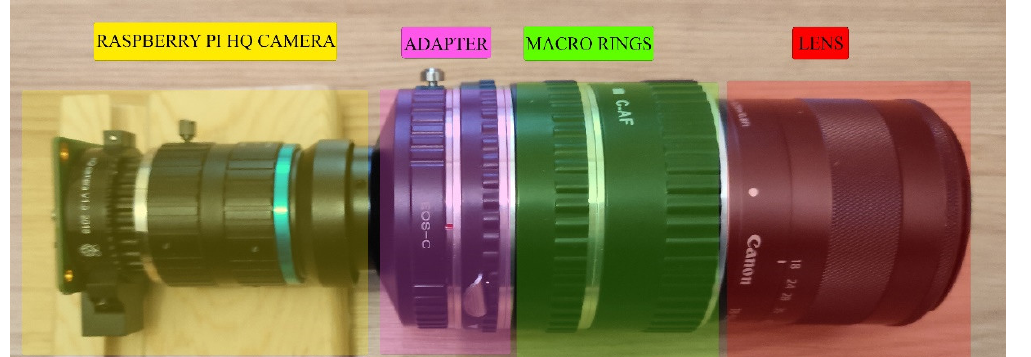
Figure 3. Raspberry Pi custom camera diagram.